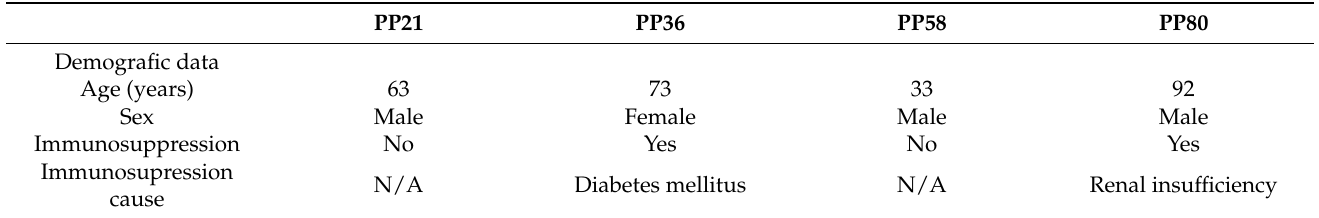
Table 1. Most relevant clinical data of the four patients who tested positive for SARS-CoV-2 in a urine sample by N15-RT-LAMP.